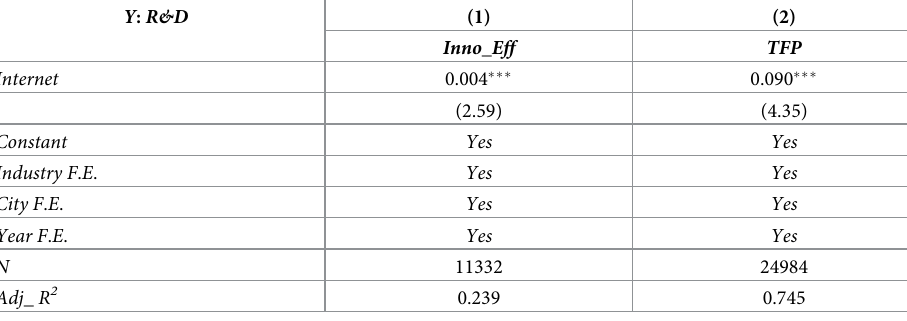
Table 6. Internet penetration, R&D efficiency, and total factor productivity.